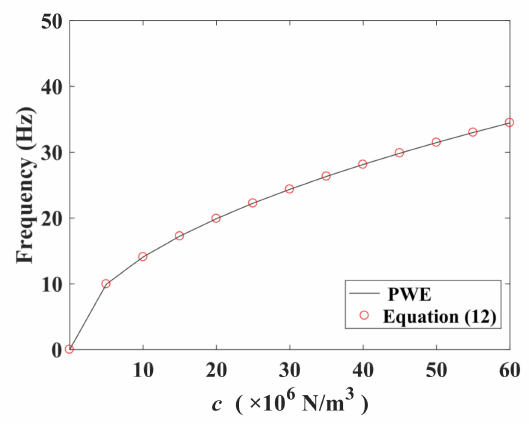
Figure 5. Two results of PWE and Equation (12).